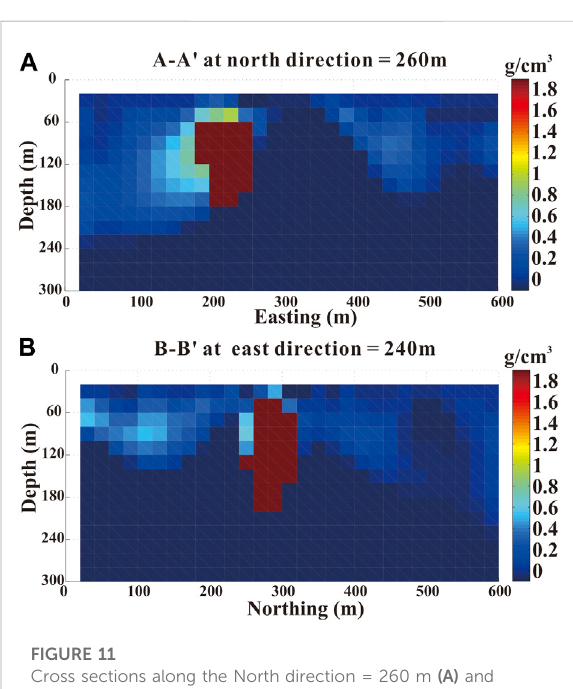
FIGURE 11 Cross sections along the North direction = 260 m (A) and along the East direction = 240 m (B) of the inversion density distribution obtained by using the inversion method discussed in this